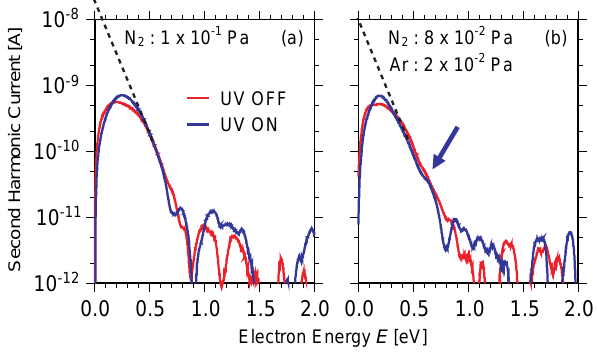
Fig. 4. Second harmonic component of thermal electrons in N 2 gas only (a) and mixture of N 2 /Ar (b) when EUV lamp was turned on (blue line) and off (red line). Pressure inside the test chamber is 1 × 10 − 1 Pa for pure N 2 gas experiment, and for mixture gas exper- iment pressure of N 2 and Ar gas were 8 × 10 − 2 Pa and 2 × 10 − 2 Pa, respectively. The blue arrow in the right panel indicates the energy where a small hump exists. Two short tip marks between two 10 increment-long tip marks indicate 2, and 5